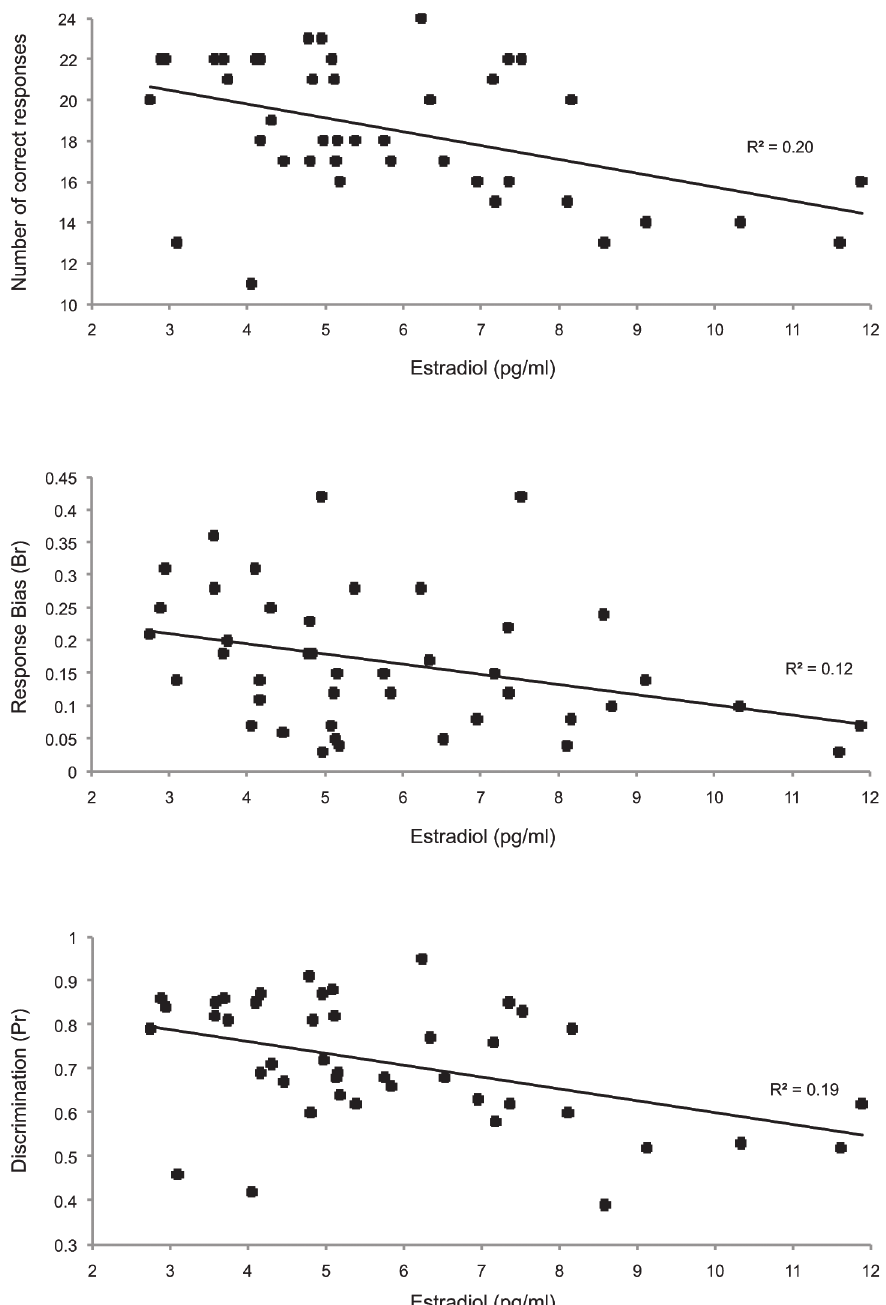
Fig 2. . Association between estradiol (pg/ml) and disgust recognition indices. Lines of best fit are shown along with R 2 indicating the degree of variance in recognition performance accounted for by estradiol.